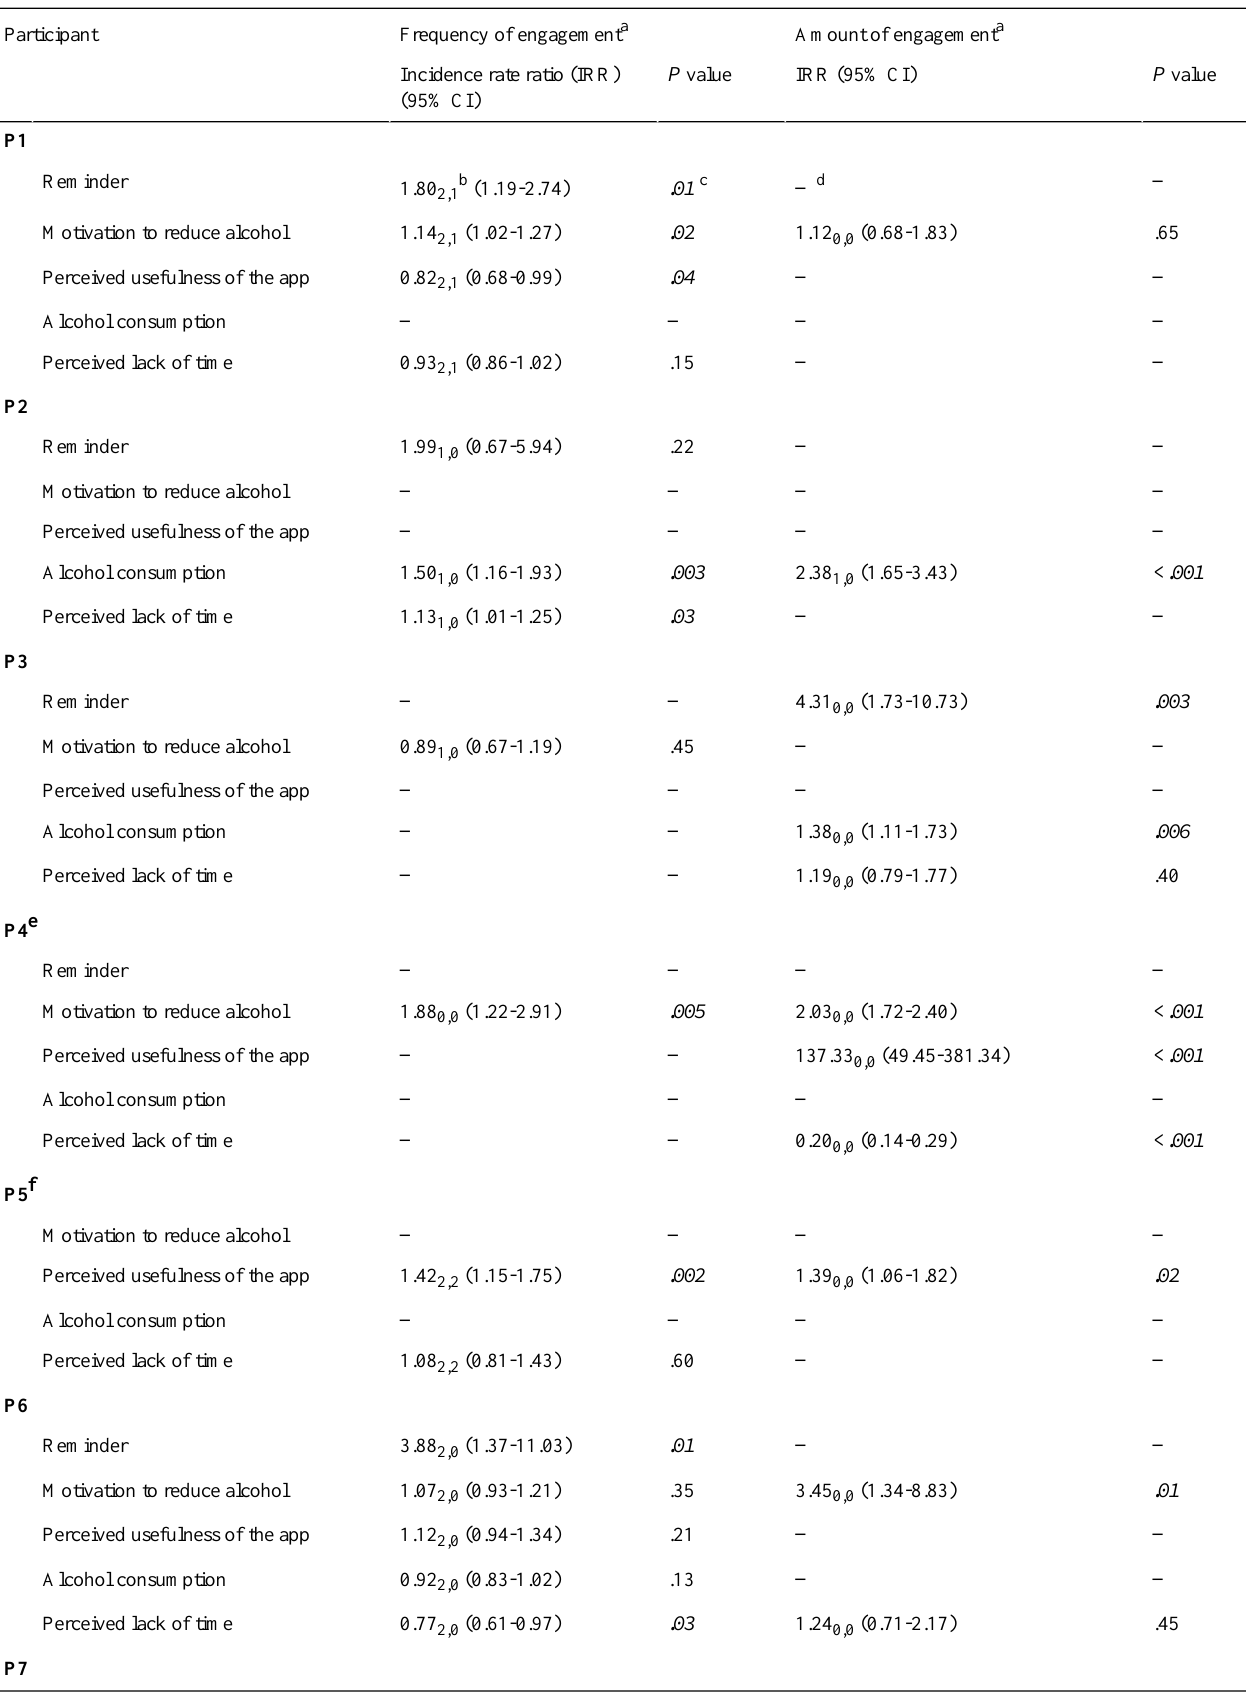
Table 6. Incidence rate ratios for the associations between the predictor and the outcome variables for each participant (P) in the multivariable generalized additive mixed